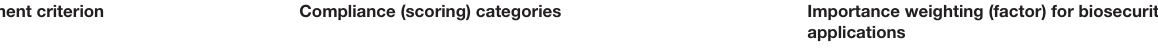
TABLE 2 | Method-related criteria (adopted from ICES, 2013; Krause-Jensen et al., 2015 and other relevant literature sources 3 − 10 ), scoring categories and importance weighting applied in this